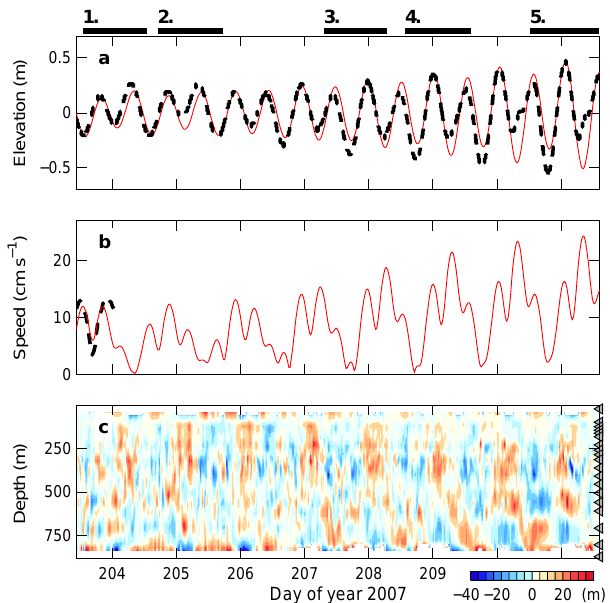
Figure 2. Time series at station 5 of (a) tidal surface elevation from STORMTIDE (red; sum of 8 major constituents) and near-bottom pressure anomaly from the deepest moored instrument (dashed), (b) tidal current from STORMTIDE (red; sum of M 2 , K 1 , S 2 and O 1 ) and depth-averaged current measured by the moored in- struments (dashed), and (c) vertical isopycnal displacements. The downloaded archived STORMTIDE global data set is limited to these four major constituents for the tidal velocity and phase. The time-average depth of the instruments are shown by triangles on the right. Bars on top show the duration of stations